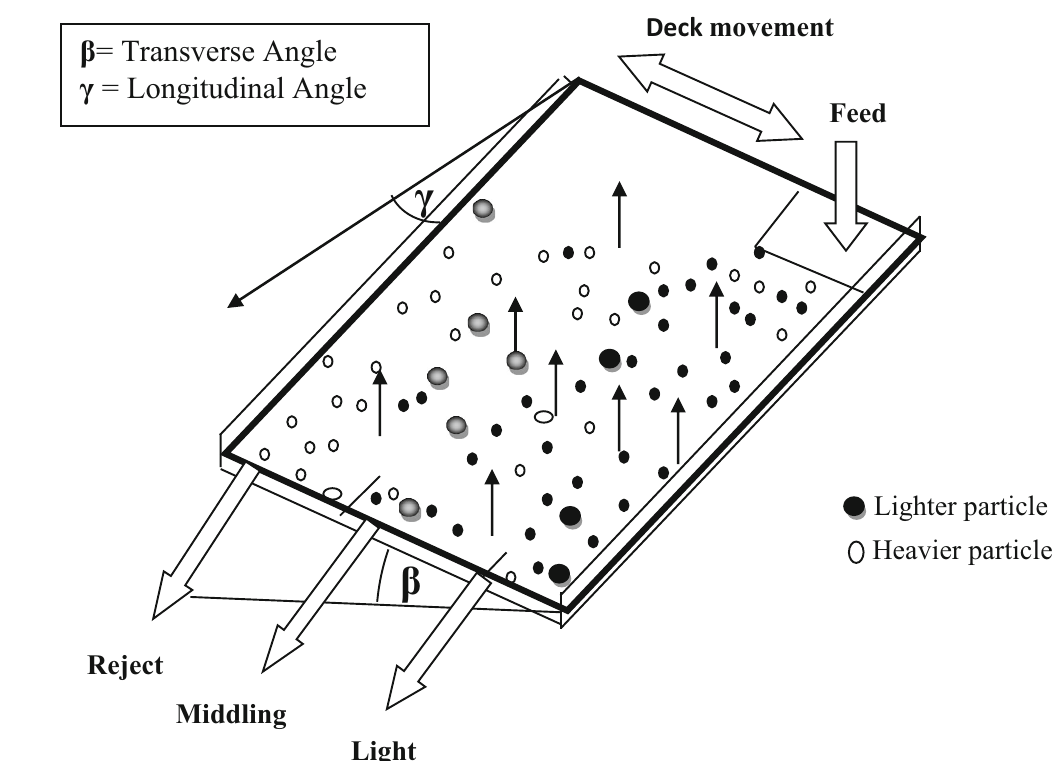
Fig. 3 Schematic diagram of air fluidized vibratory deck separator